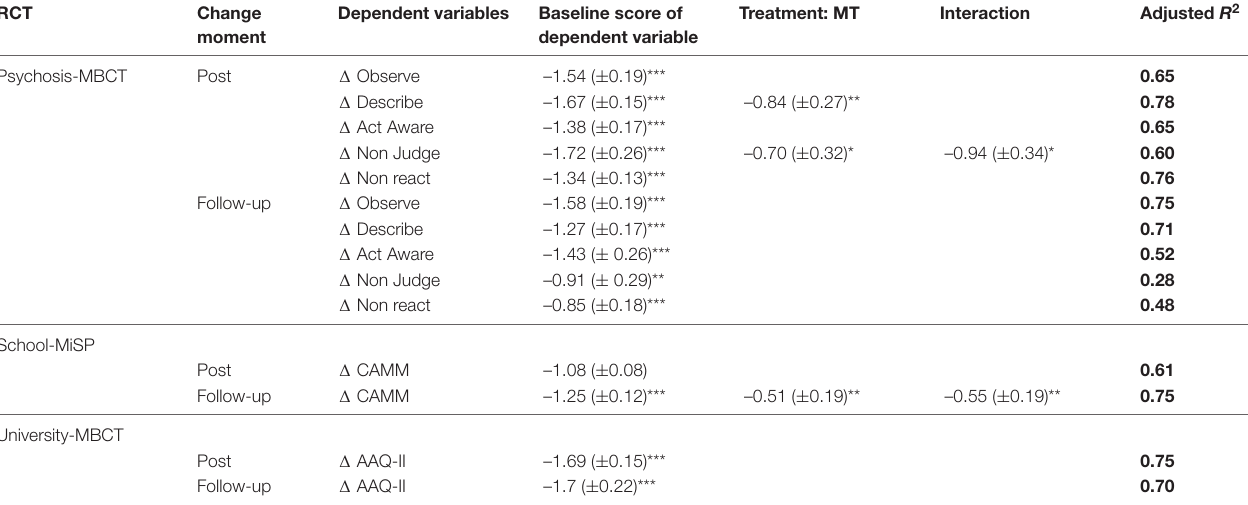
TABLE 3 | Summary of mindfulness multiple linear regression models.